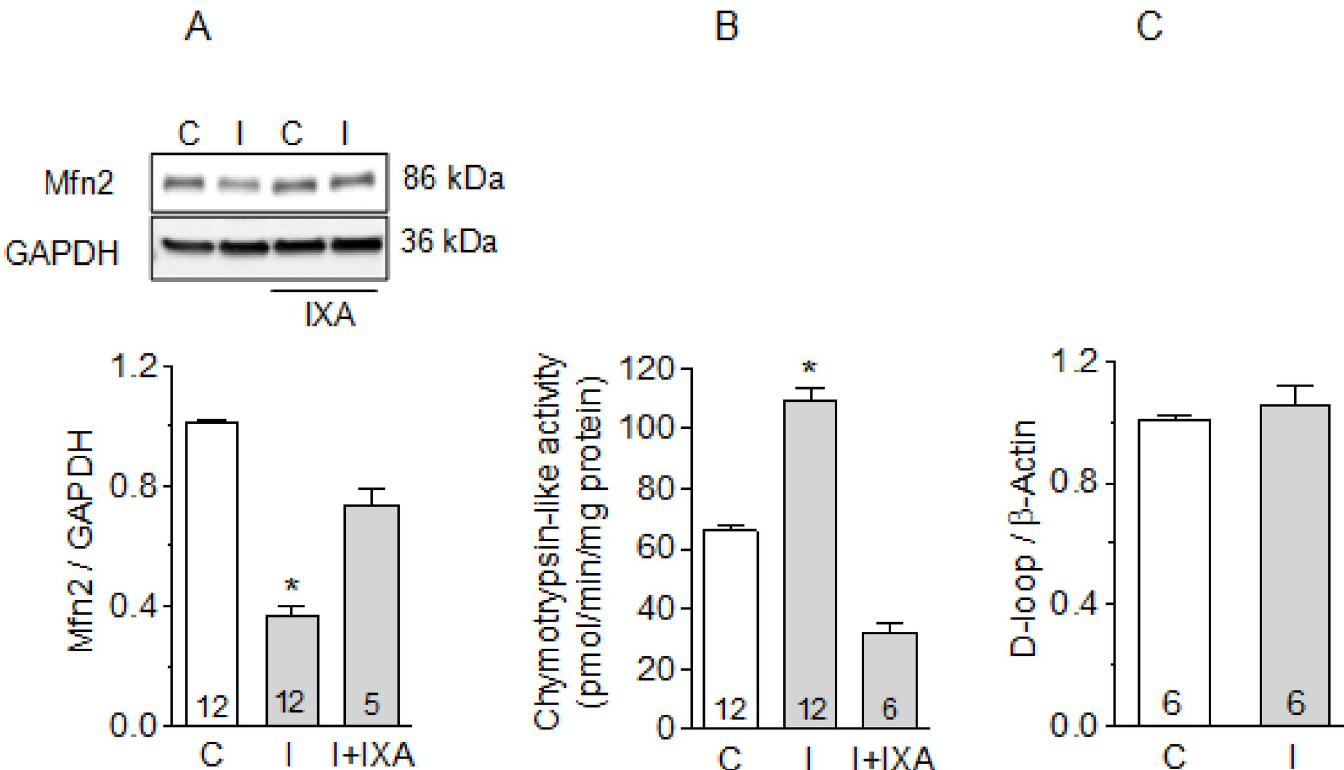
Fig 1. Effect of ixazomib on mitofusin-2 content and proteasome activity after ischemia. (A) Mitofusin-2 content in control hearts, after 30 minutes of ischemia, or after ischemia in hearts previously perfused with IXA. Representative Western blots are shown at the top. (B) Chymotrypsin-like activity of the proteasome in control hearts, after ischemia, or after ischemia in hearts previously perfused with IXA. (C) mtDNA (D-loop) to nDNA ( β -actin) by real-time quantitative PCR in control or ischemic hearts. Labels: C, control hearts, I: ischemic hearts. Bars show the average ± SEM of the number of hearts shown in each bar. � p < 0.05 vs. all other conditions. #p < 0.05 vs. C; Kruskal-Wallis test followed by Dunn‘s test.